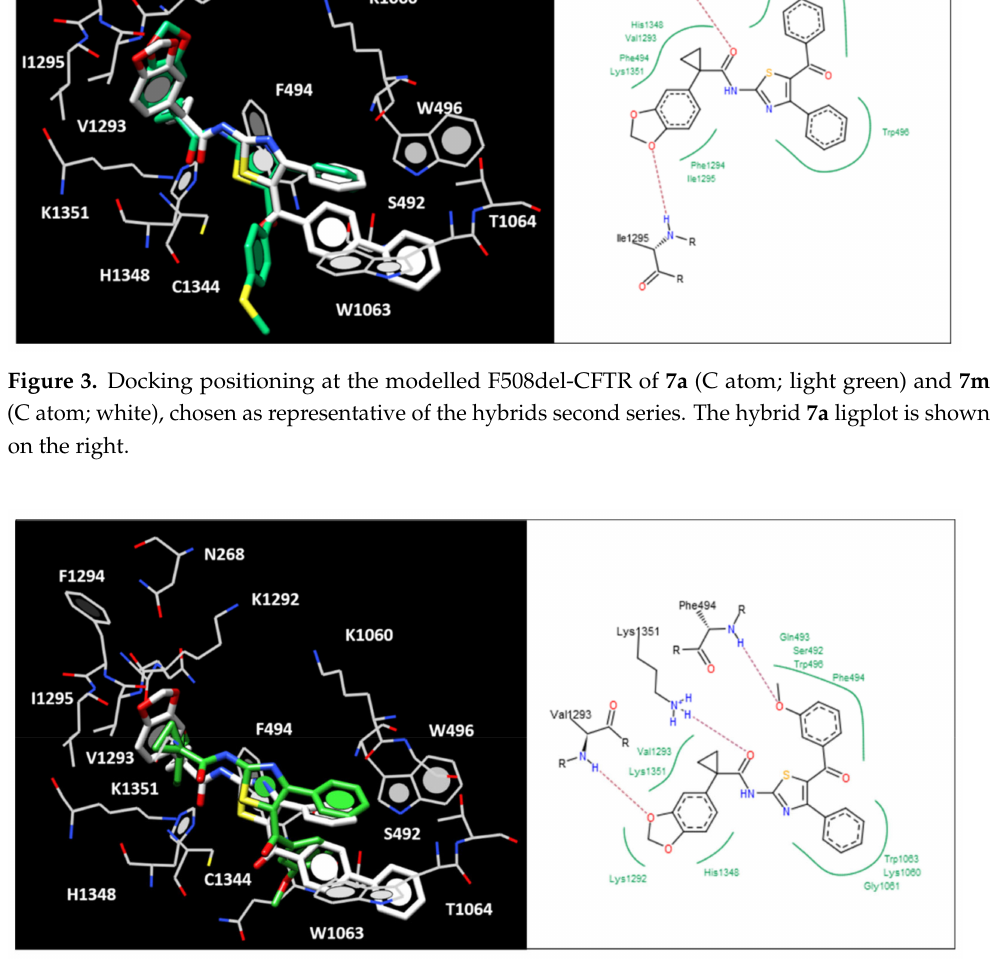
Figure 4. Docking positioning at the modelled F508del-CFTR of 7q (C atom; light green) and 7m (C atom; white). The hybrid 7q ligplot is shown on the